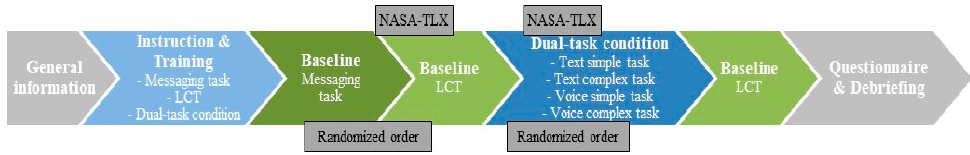
Figure 3. Procedure of the experiment.